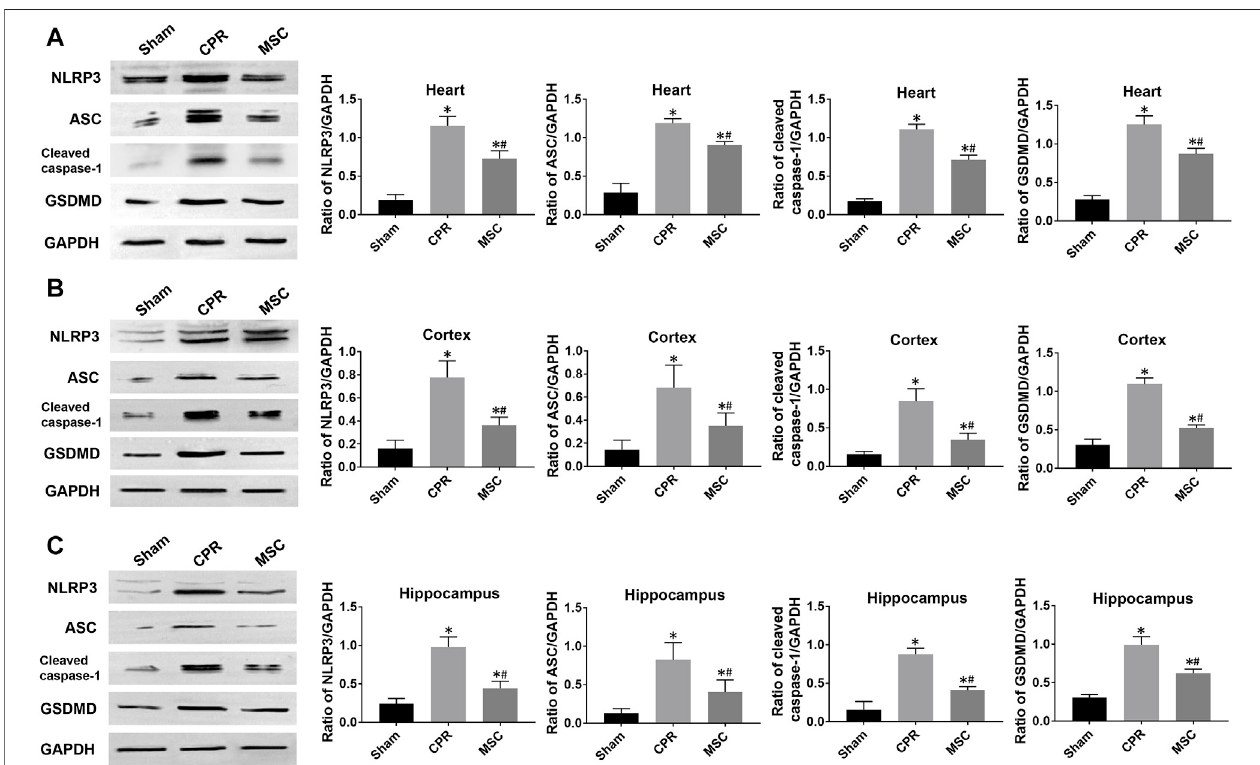
FIGURE 6 | Expression of pyroptosis-related proteins (A) – (C) The expression levels of NLRP3, ASC, cleaved caspase-1 and GSDMD in the heart, cortex and hippocampus. NLRP3, NOD-like receptor protein 3; ASC, apoptosis-associated speck-like protein containing a caspase recruitment domain; GSDMD, gasdermin D; CPR, cardiopulmonary resuscitation; MSC, mesenchymal stem cell. * p < 0.05 versus sham group; # p < 0.05 versus CPR group.